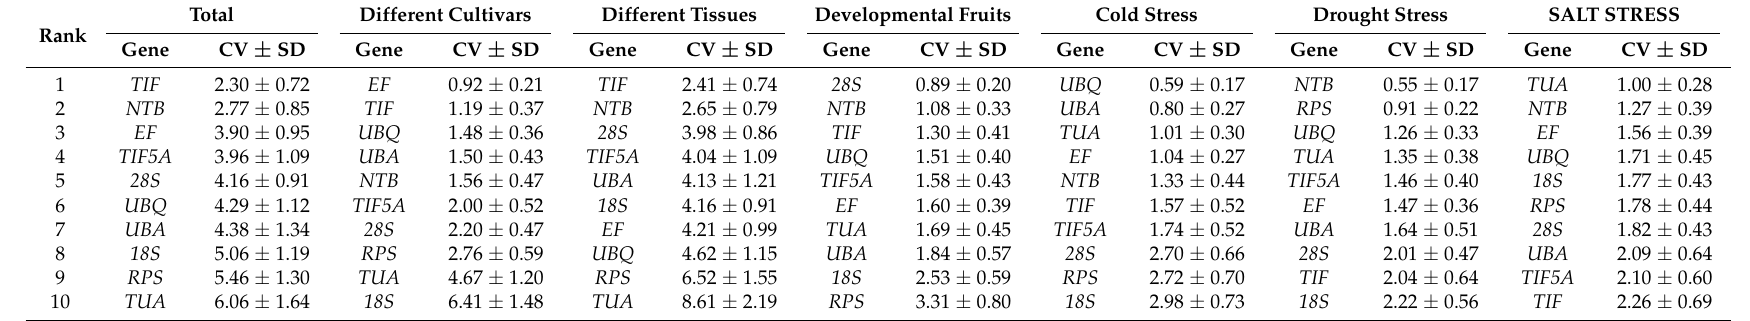
Table 5. Expression stability values of the ten candidate reference genes ( 18S , 28S, EF, UBA, UBQ, TIF, NTB, TUA, RPS , and TIF5A ) calculated using BestKeeper. Different Cultivars Different Tissues Developmental Fruits Cold Stress Drought Stress SALT